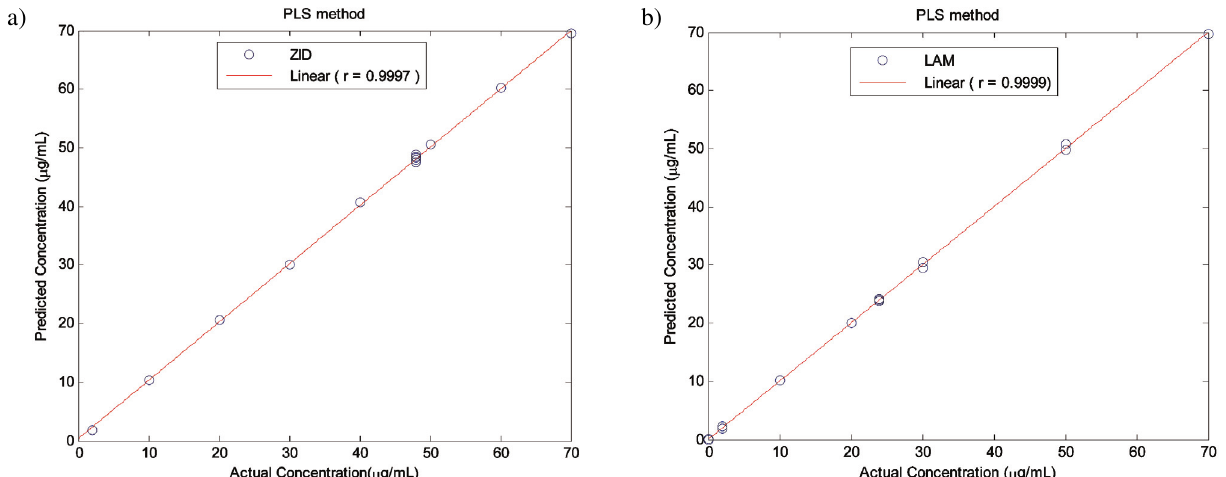
Figure 3. Plot of the actual and predicted concentrations in the prediction step by using the PLS method with four components for ZID (a) and LAM (b) drugs